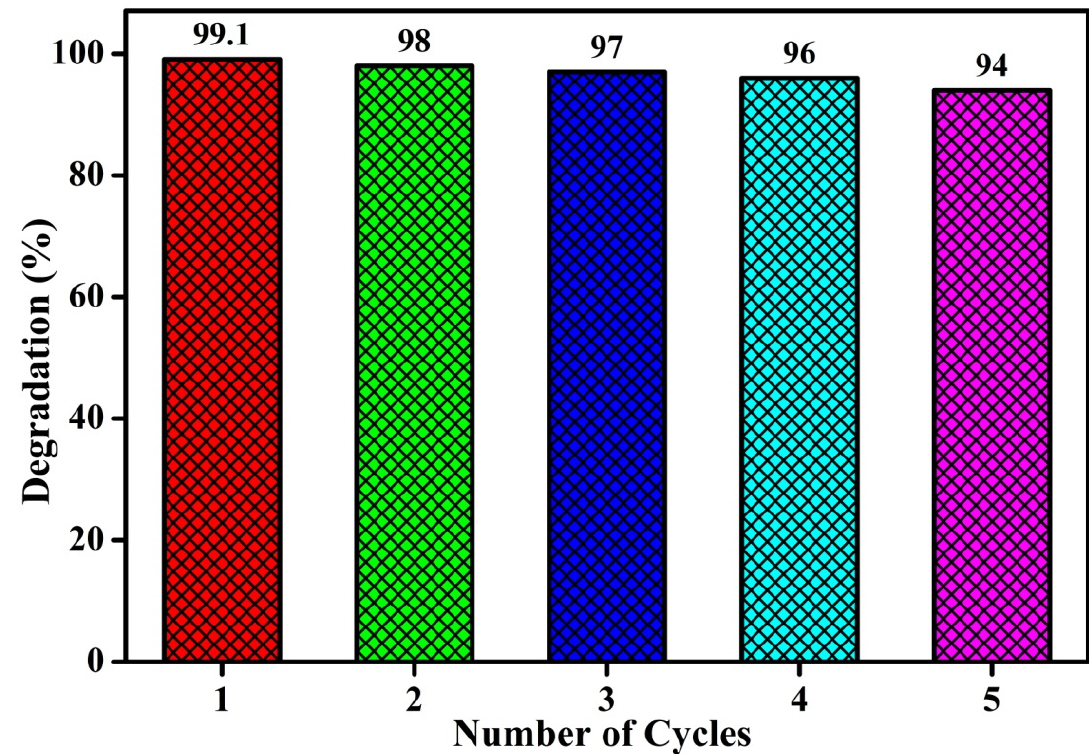
Figure 7. Reusability of TZU75 for MO degradation under UV light irradiation.